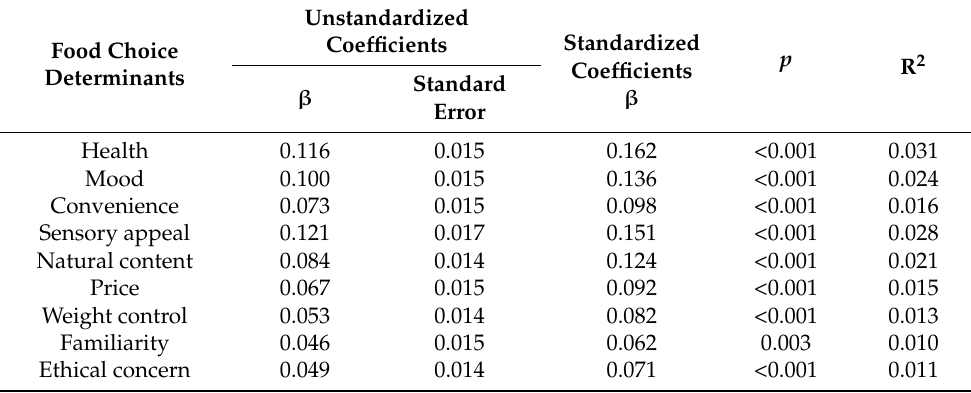
Table 4. Analysis of association between food choice determinants assessed by Food Choice Question- naire (FCQ) and fruit preference assessed by Food Preference Questionnaire (FPQ) (model adjusted for sex and age) within the population of the second phase of the Polish Adolescents’ COVID-19 Experience (PLACE-19) Study ( n =